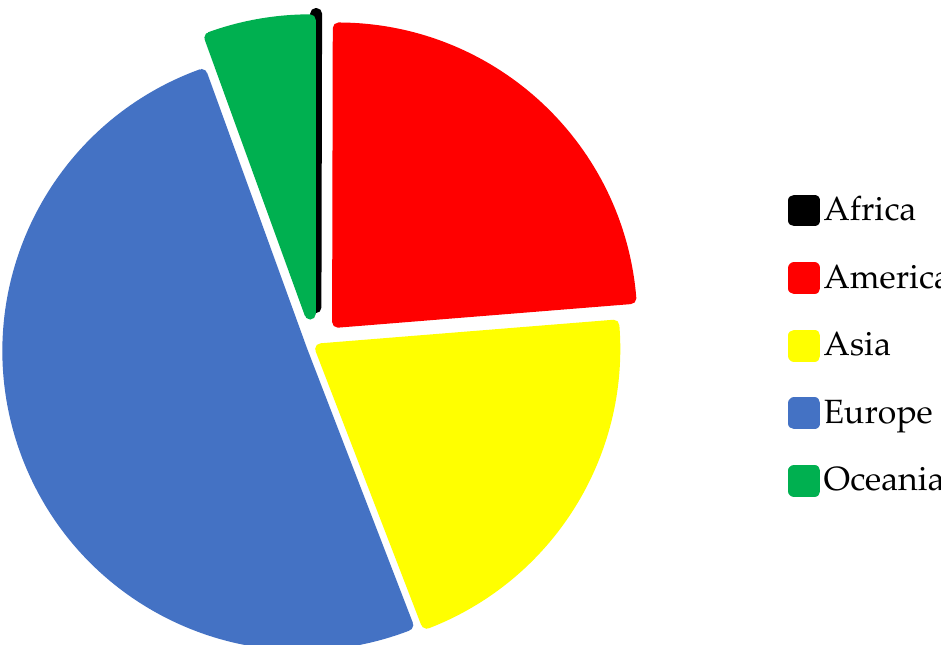
Figure 1. Distribution of fungal species in culture collections on different continents.